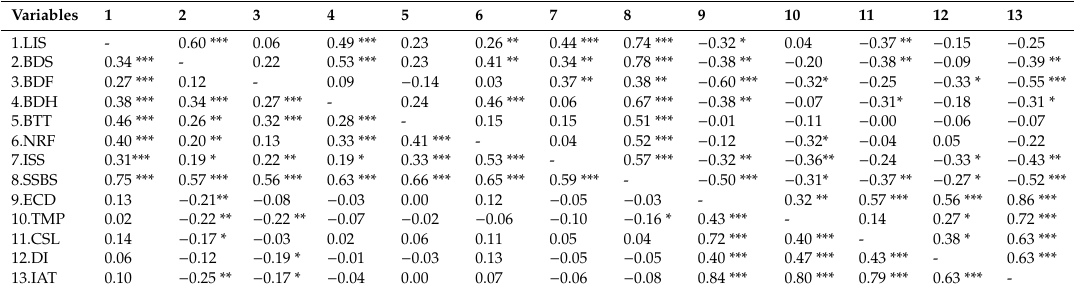
Table 1. Sex di ff erences of the correlation coe ffi cients of Problematic Internet Use and Student School Burnout (N female = 170, N male = 59).